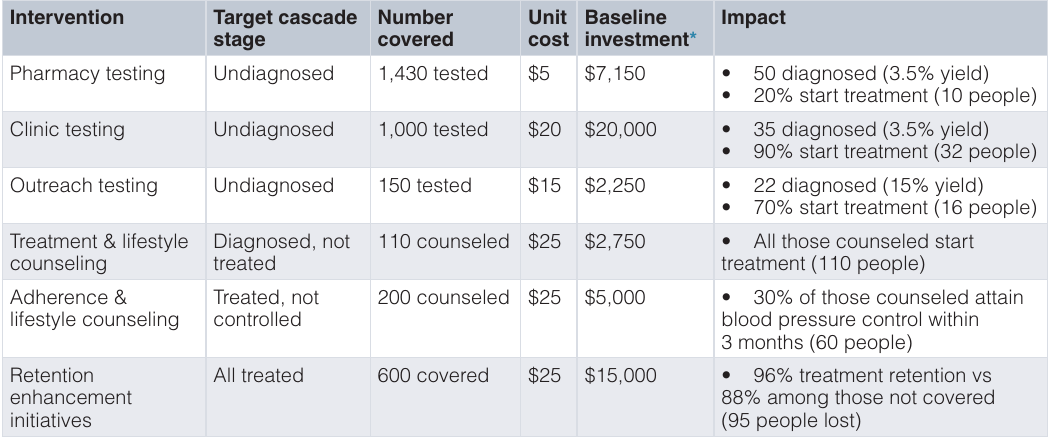
2.Table 1. Illustrative data on interventions for the hypertension example presented in Figure